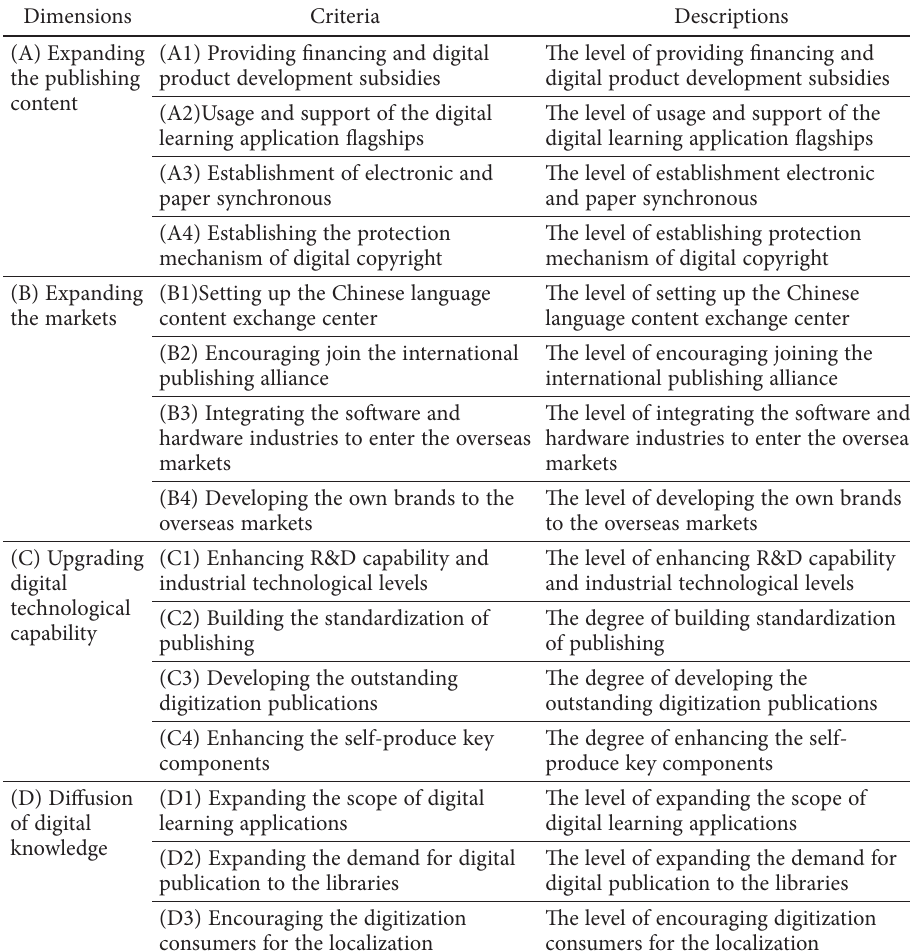
Table 1. The dimensions and criteria for DPT